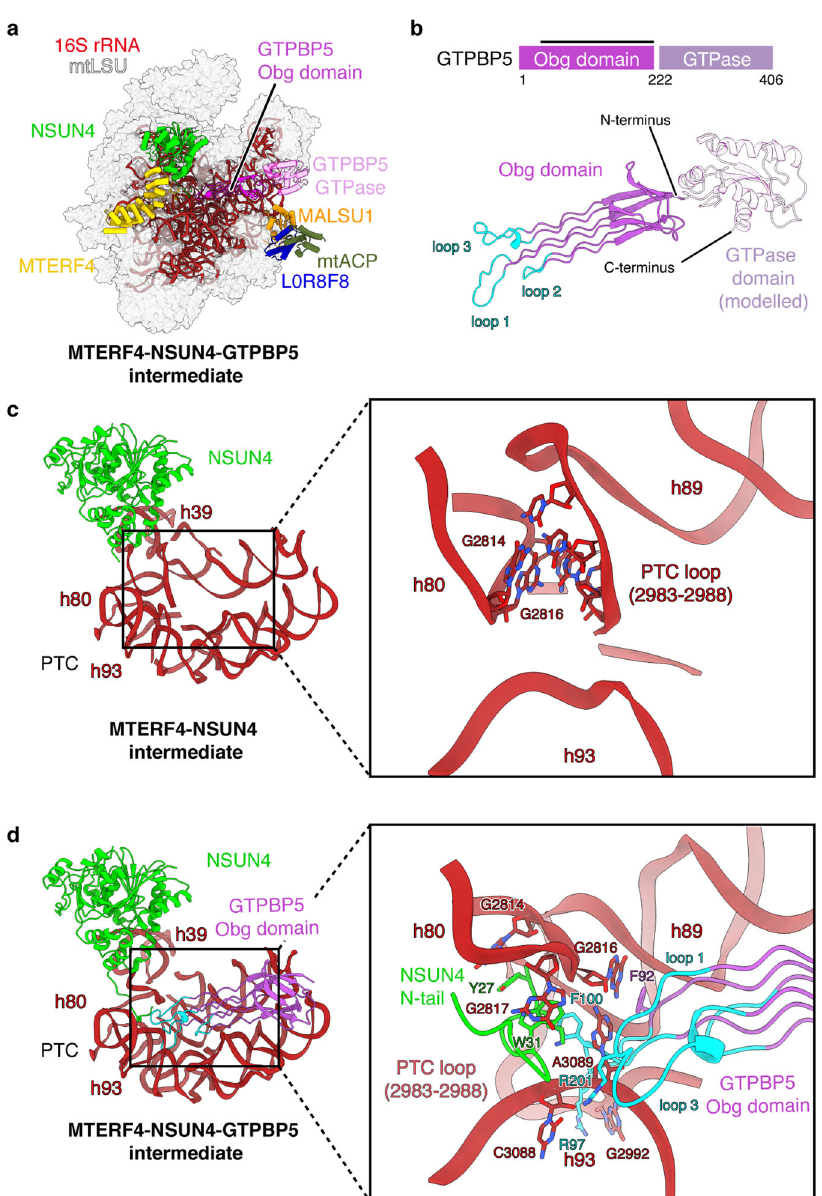
Fig. 2 GTPBP5 cooperates with NSUN4 to mature the PTC. a Cryo-EM structure of MTERF4-NSUN4-GTPBP5-bound large mitoribosomal subunit (mtLSU) intermediate (dataset 1). Depiction as in Fig. 1a with GTPBP5 shown in pink. b Structure of human GTPBP5. The protein is depicted schematically on top, with domain annotation indicated by coloring and residue numbers. The black bar above represents regions modeled in the structure. A homology model of the GTPase domain is shown transparently, but was not included in the fi nal model. The conserved loops 1 – 3 that contact bases of the peptidyl transferase center (PTC) are shown in cyan. c , d The P loop/h80, h93, and PTC loop undergo rearrangements upon GTPBP5 binding. Closeup view of the PTC in the NSUN4-MTERF4 ( c ) and NSUN4-MTERF4-GTPBP5 ( d ) mtLSU assembly intermediates. The rRNA and proteins are shown as cartoons, with coloring as in Fig. 1. Selected bases that undergo rearrangements are indicated and highlighted as sticks. Loop 1 and 3 of GTPBP5 and the N-terminal tail of NSUN4 are shown as cartoons and residues that interact with the indicated bases are shown as